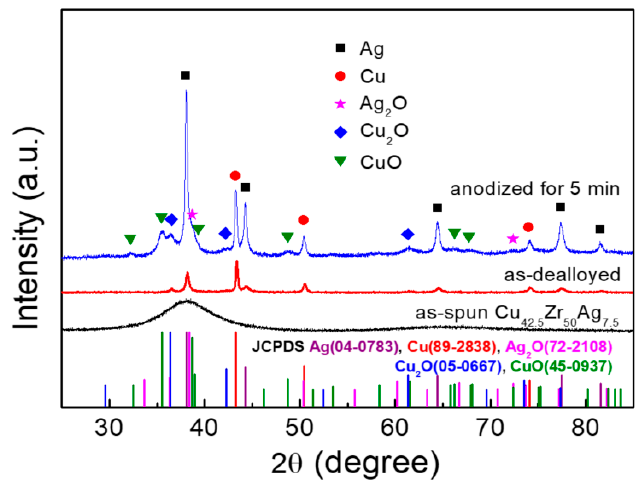
Figure 2. XRD patterns of the as-spun, as-dealloyed and as-prepared sample after anodizing for 5 min followed by calcination.